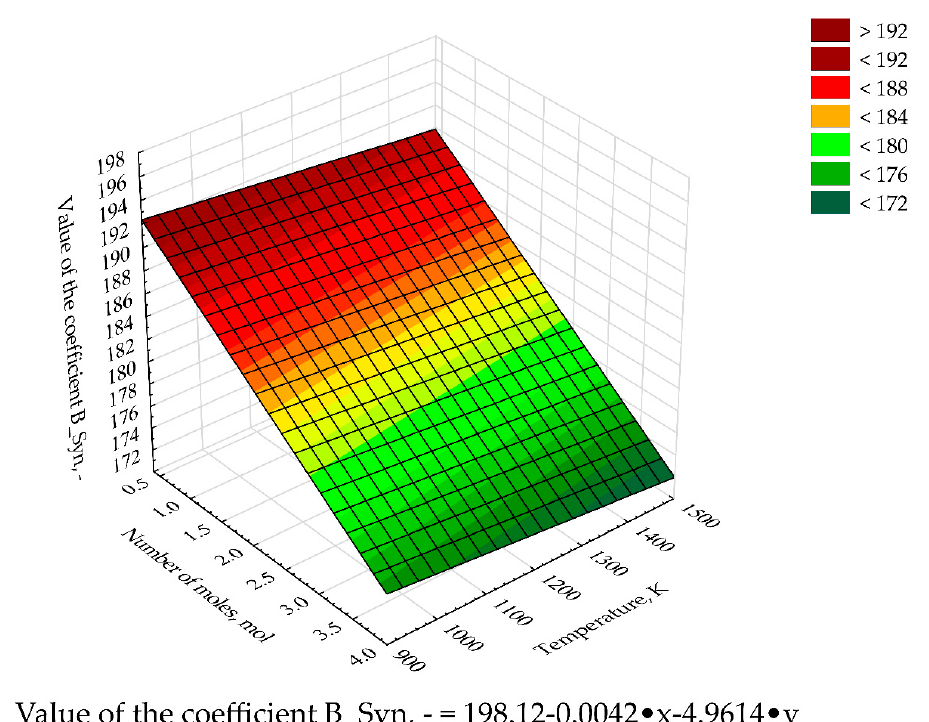
Figure 20. The value of the syngas compression ratio as a function of the number of moles of the gasification agent (x) and the temperature (y) of the gasification process using H 2 .